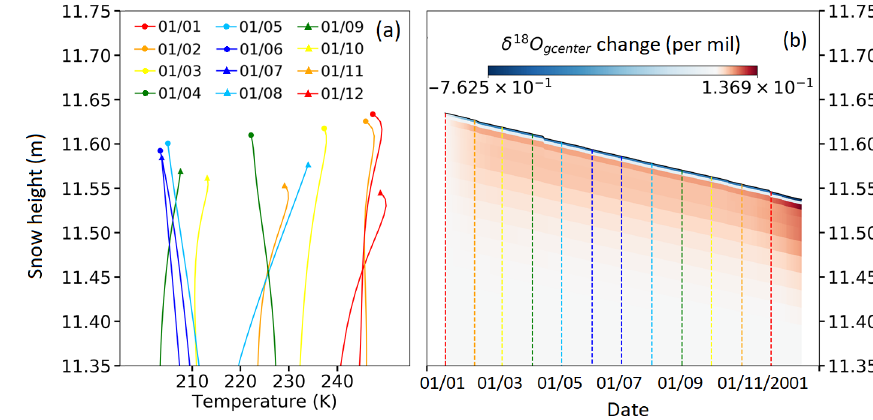
Figure 6. Simulation 4: cumulative change in δ 18 O gcenter values (vapor transport, compaction, and wind drift active).